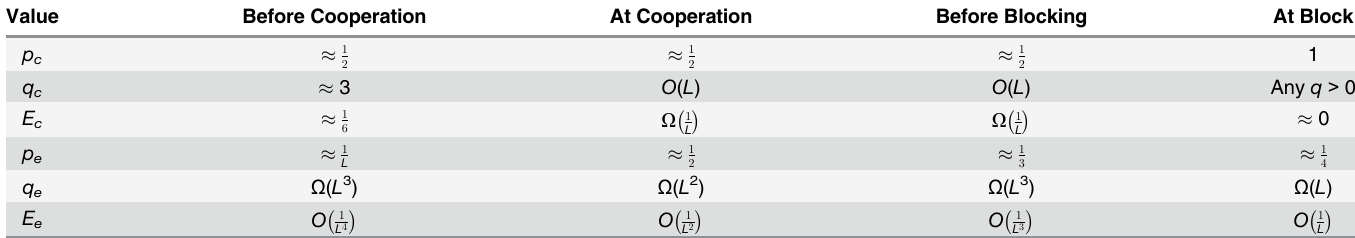
Table 1. Efficiency of a cooperative assembler at temperature τ = 2 and its noncooperative implementation at temperature τ = 1. The substantial drop in the probability of assembly with respect to the target set and its efficiency show the lack of robustness of the original assembler. Nevertheless, the data shows that some cooperation is better than none for efficiency of the